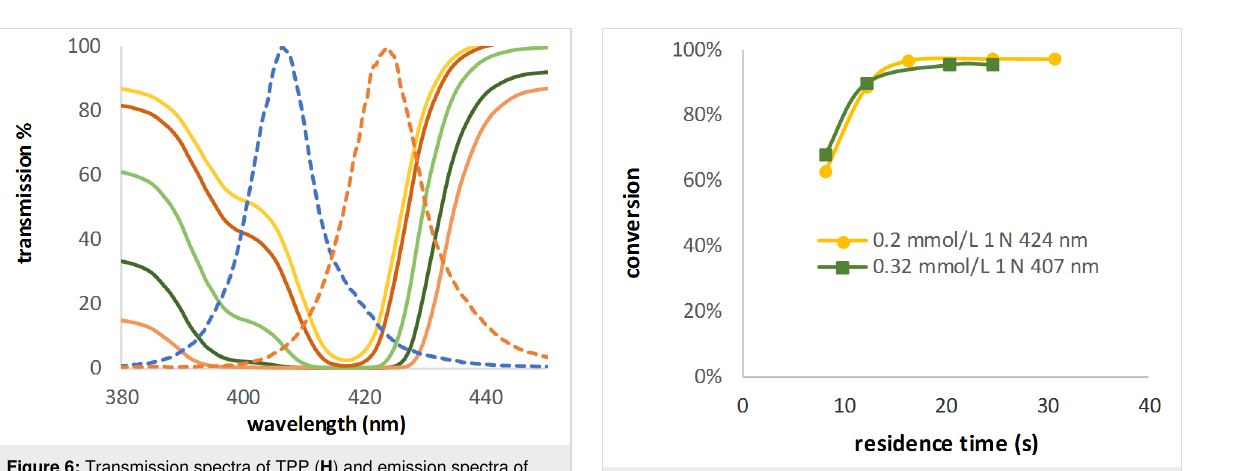
Figure 7: Conversion of alpha-terpinene using the wavelength- adapted TPP ( H ) concentrations.